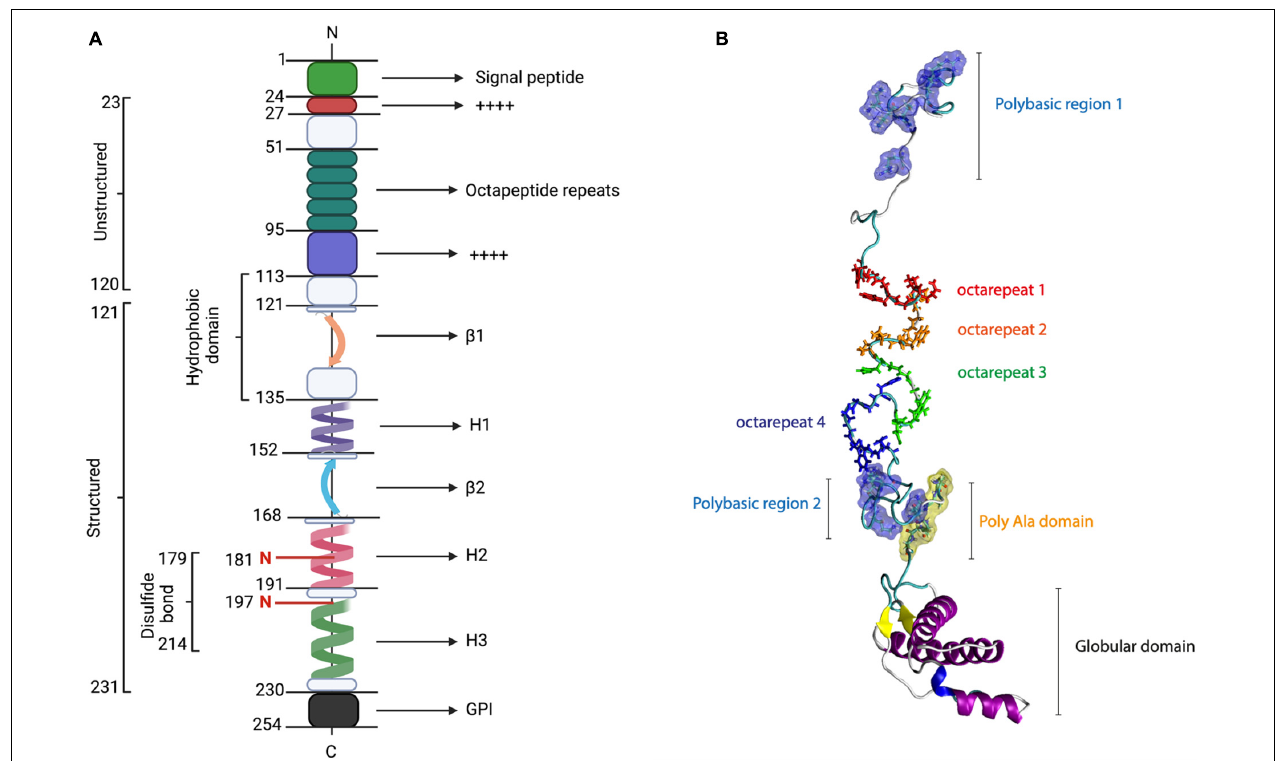
FIGURE 1 | PrP structure. PrP C consists of 253 amino acids, which include the signal peptide (1–22), five octarepeat regions, a hydrophobic region (113–135), a disulfide bond between its cysteine residues 179 and 214, two N -glycosylation sites (residues 187 and 197), and a GPI anchor at its C-terminal. The structured conformation between amino acids 121 and 231 corresponds to a globular domain, which contains two β -sheets and three α -helices. (A) Linear representation of PrP sequence [modified from Acevedo-Morantes and Wille (2014)]. (B) PrP